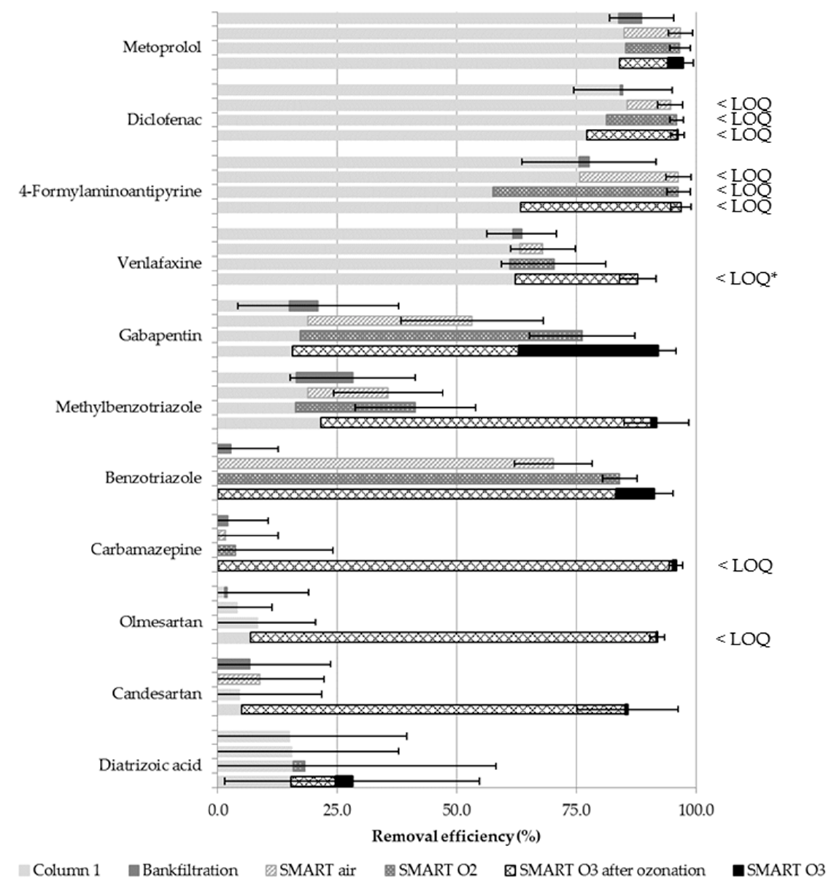
Figure 4. Removal efficiency (%) of all quantified trace organic chemicals (TOrCs) which were not degraded below the limits of quantification (LOQ) in the first column ( n ≥ 8). (* Venlafaxine was degraded below LOQ during ozonation whereas an increase of the concentration up to 65 ± 13 ng/L in the following filtration step was observed.)